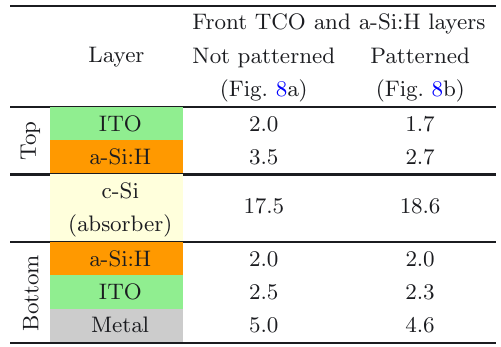
Fig. 8. Description of the two optimized structures by 3D FDTD and genetic algorithm for a 1.1 μ m thick HIT solar cell (same legend as Fig. 1). Table 2. Photonic current densities calculated by integration of the absorbed photons in each layer (mA cm − 2